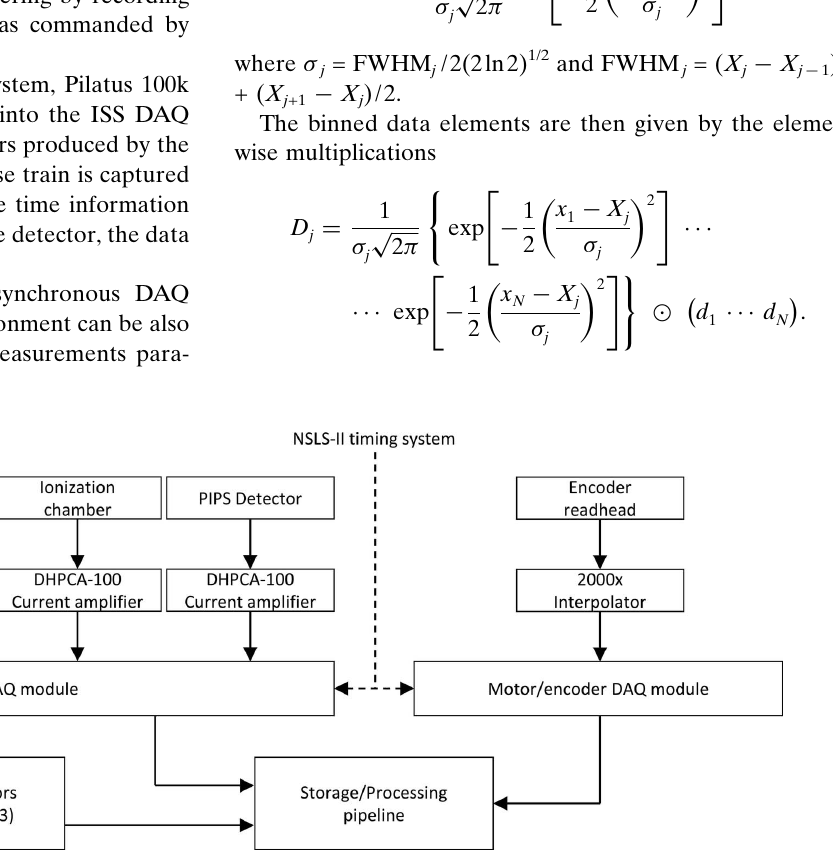
Figure 6 Data acquisition scheme implemented at the ISS beamline. The dashed lines represent the flow of timing signals and solid lines represent the flow of experimental signal/data